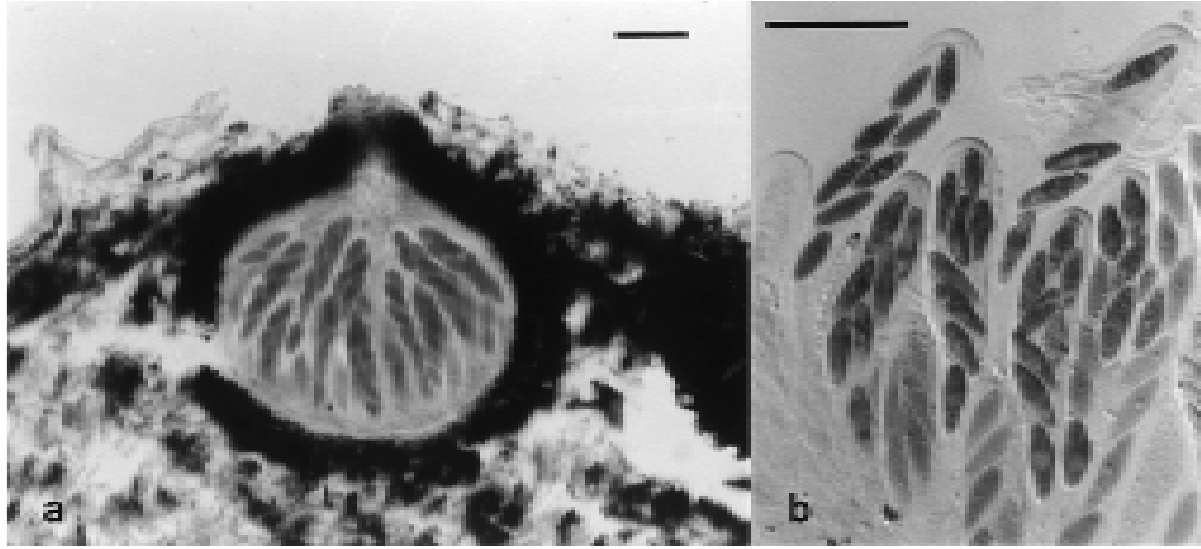
Fig. 3. Botryosphaeria dothidea on grapevine canes. a. Ascoma, b. asci. Scale bars = 50 µ m.